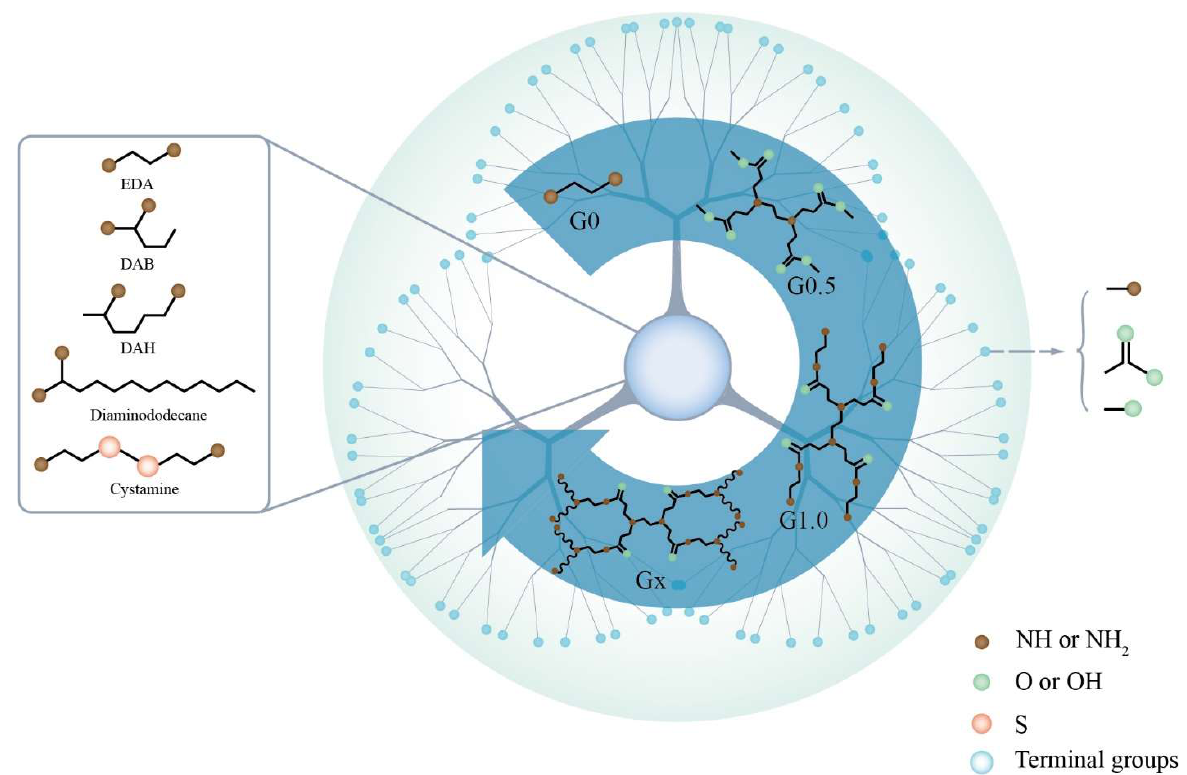
Figure 1. Schematic diagram of the structure of PAMAM. Schematic showing the chemical struc- ture of PAMAM, including the core, terminal groups and different generations. EDA: ethylenediamine; DAB: diaminobutane; DAH: 1, 5-diaminohexane.